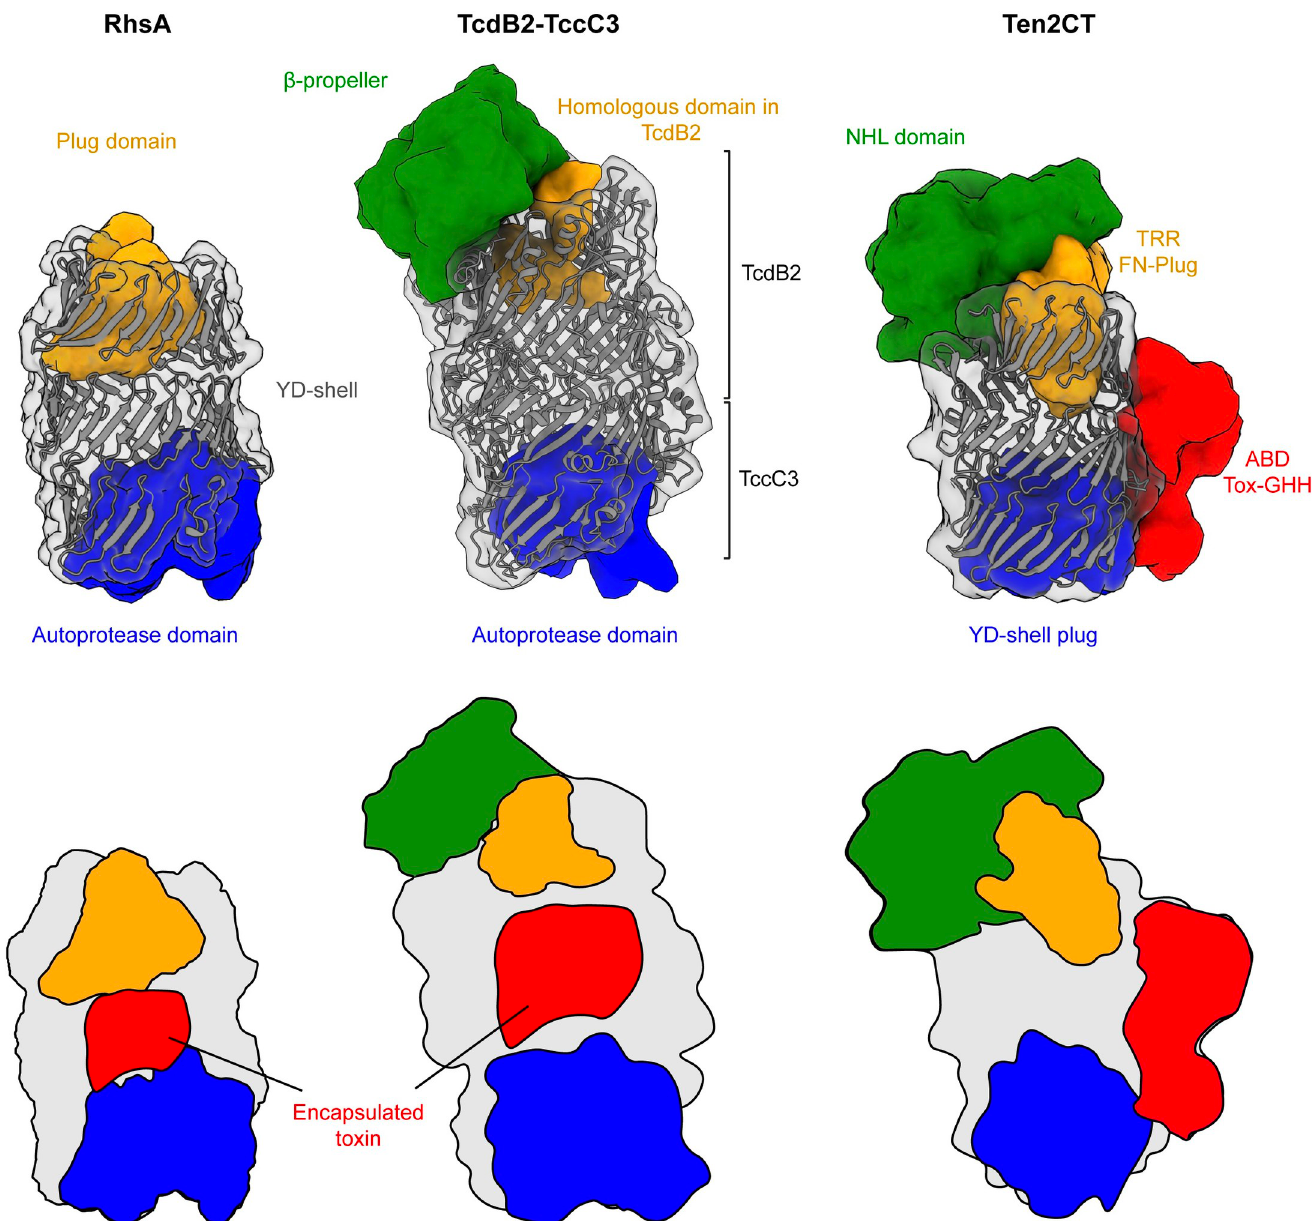
Fig 4. Structural comparison of Rhs repeat containing proteins. The C-terminal autoproteolysis domain (left and middle) or YD-shell plug (right) is structurally conserved among diverse Rhs proteins (blue). RhsA and BC components of Tc toxin complexes encapsulate their toxic effector domains (red) whereas in teneurin proteins the toxin domain is appended to the outside of the Rhs barrel (red). A distinguishing feature of these Rhs proteins is the unique N-terminal plug domain for each protein family (orange). RhsA is capped by a cork-like plug domain that seals the Rhs barrel (orange). In Tc toxins, the homologous plug domain acts as constriction site and the cocoon is sealed off by a β -propeller domain (green). Teneurin proteins are capped with a non-homologous FN-plug (orange) that is stabilized by an NHL domain (green). The lower row shows schematic representations of the domain